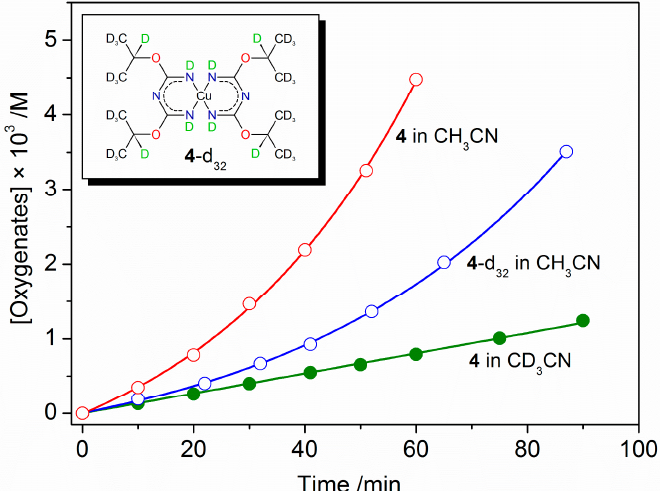
Figure 8. Accumulations of the main reaction products (cyclohexanol and cyclohexanone) with time in the oxidation of cyclohexane (0.2 M) catalysed by 4 (1 × 10 − 3 M, red blank circles) or 4 -d 32 (1 × 10 − 3 M, green blank circles) in the presence of pyridine (0.01 M) in CH 3 CN (blank circles) or CD 3 CN (solid circles) at 50 °C. Solid lines are exponential or linear fits.